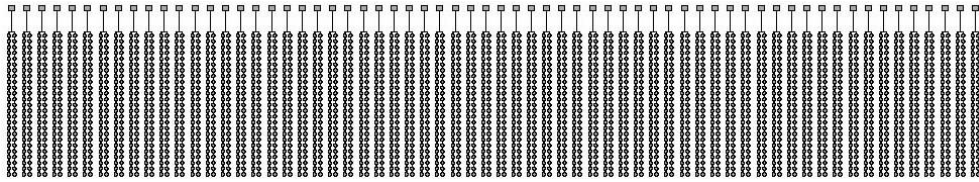
Figure 2. Sixty four CMUT linear array